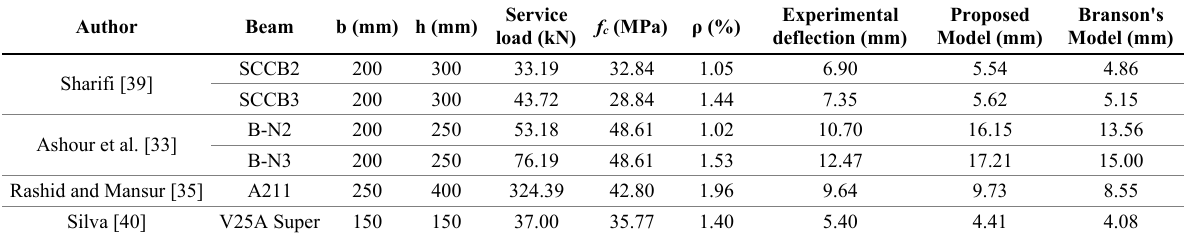
Table A2. Beams data with f c from 20MPa to 50MPa and reinforcement rate from 1% to 2%.